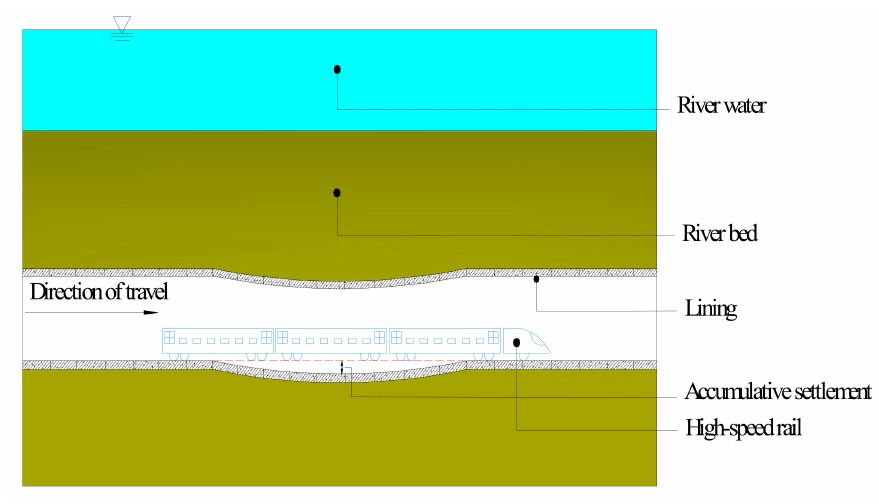
Figure 1. Schematic diagram of cross-river subway settlement.